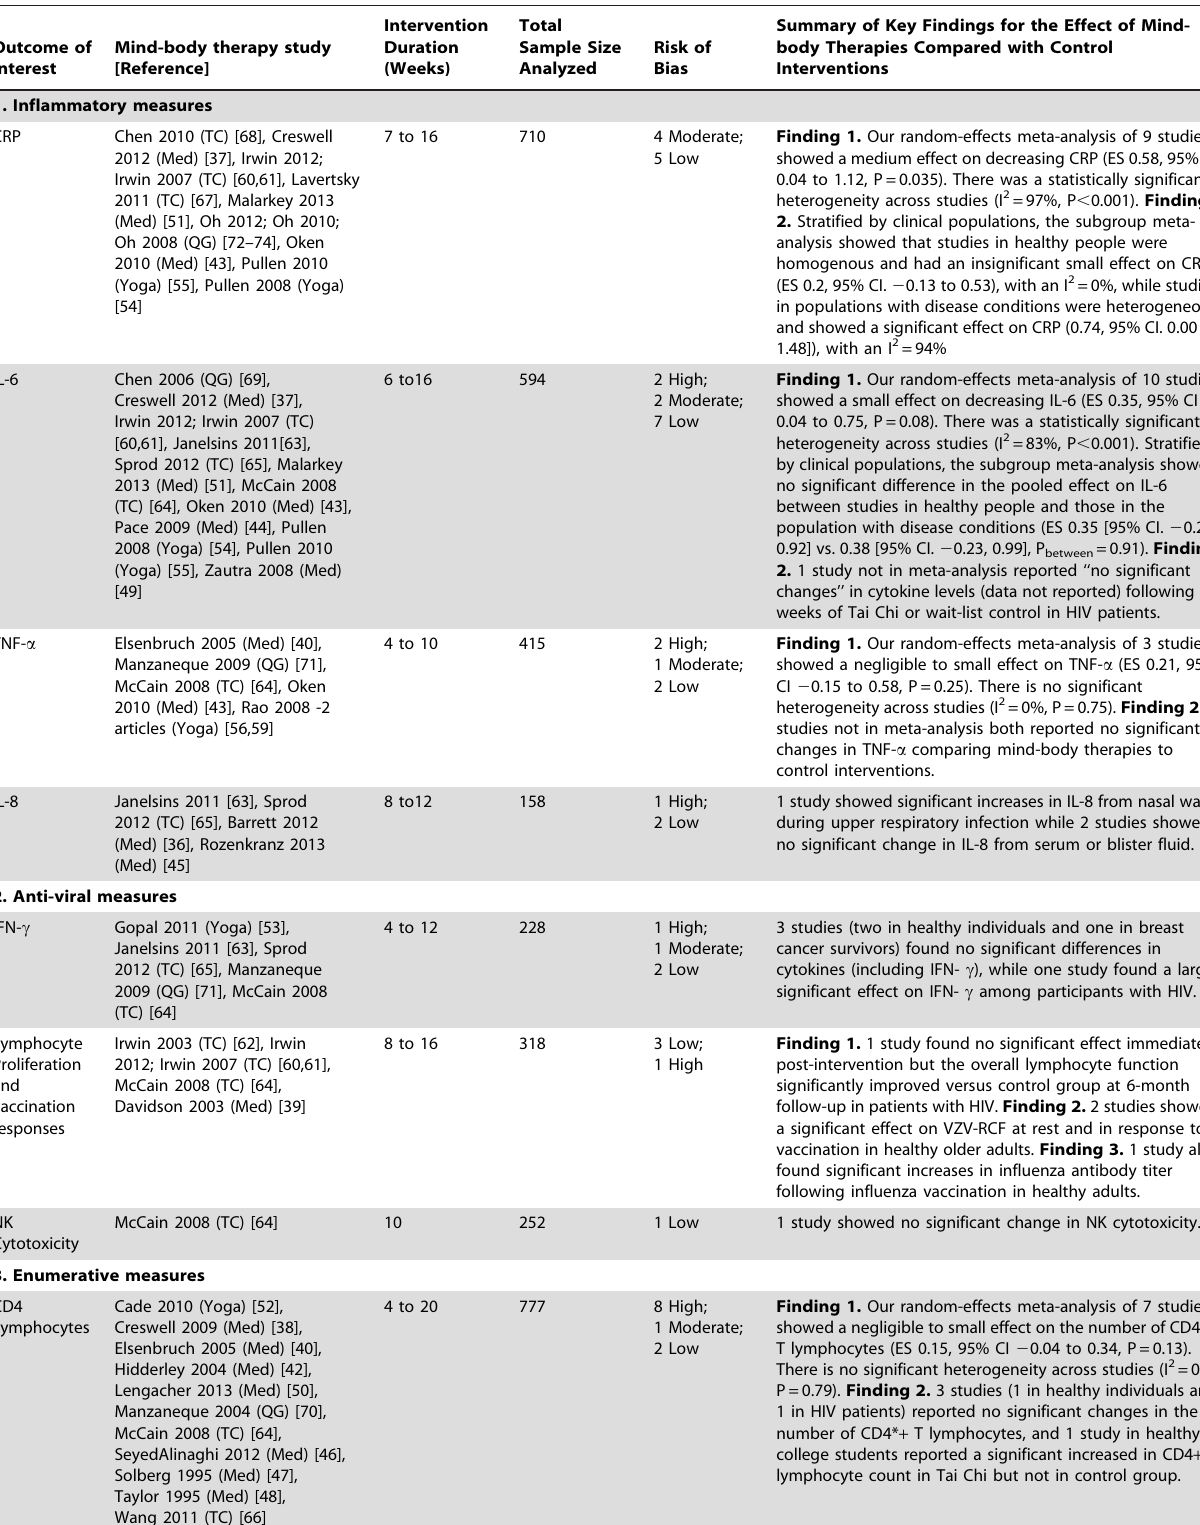
Table 2. Summary of Evidence Reviewed Categorized by Inflammatory and Antiviral Outcomes.